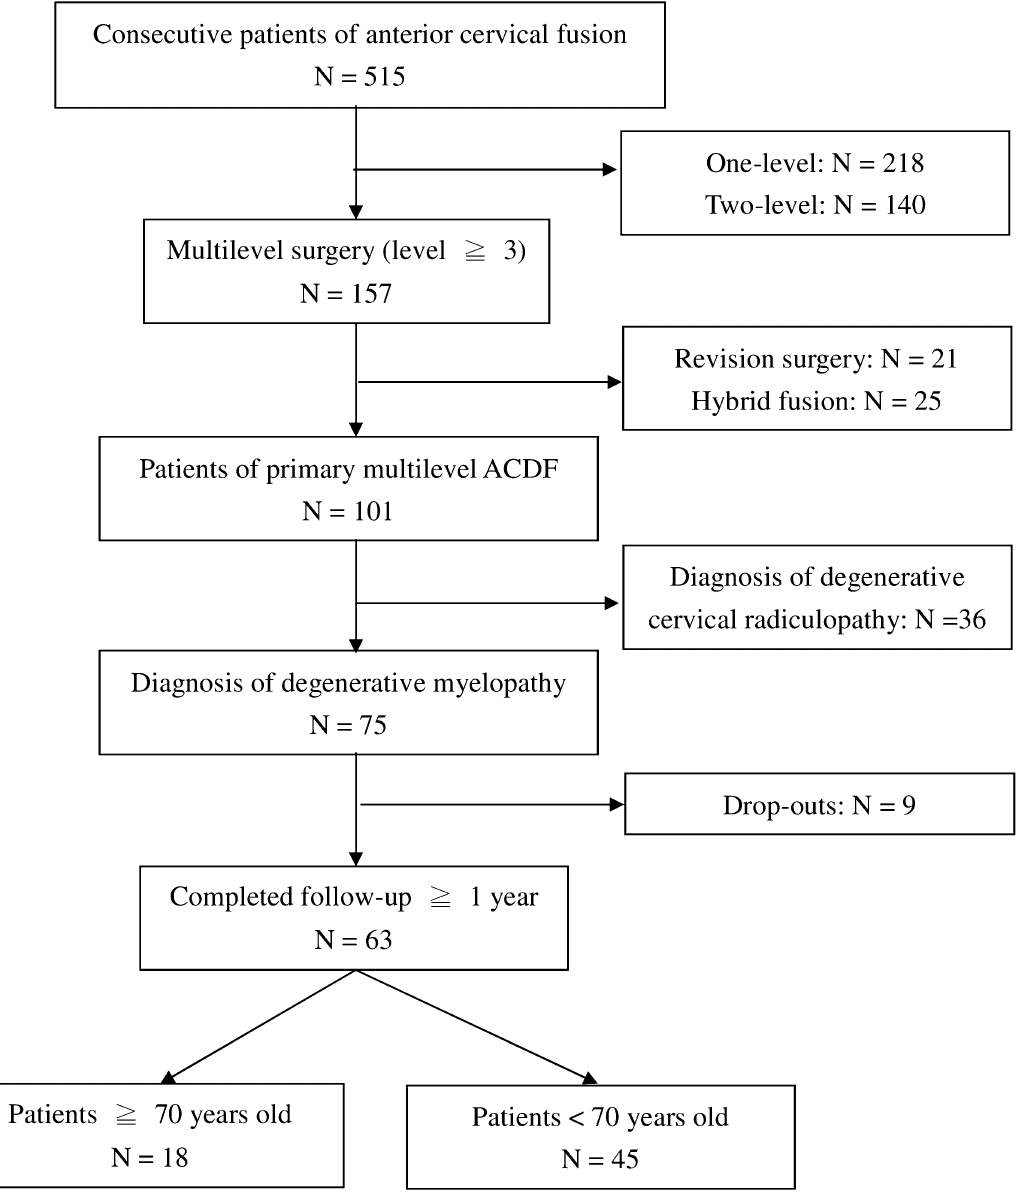
Figure 1. Flow diagram of numbers of individuals at each stage of